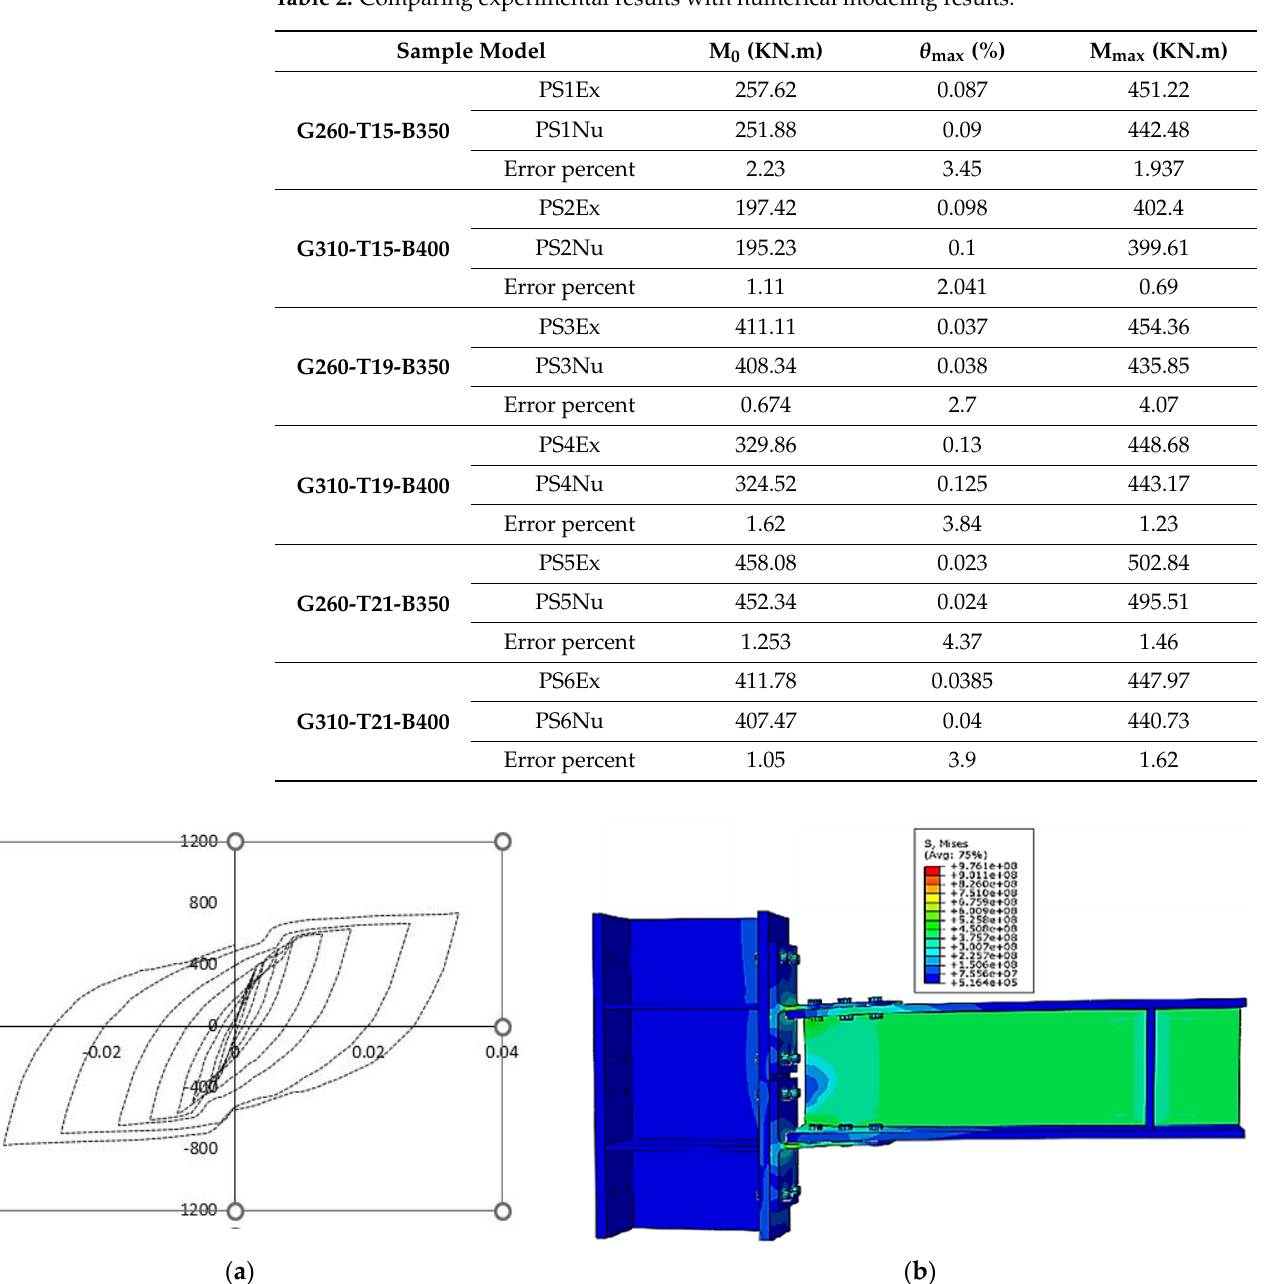
Table 3. Developed finite element models.